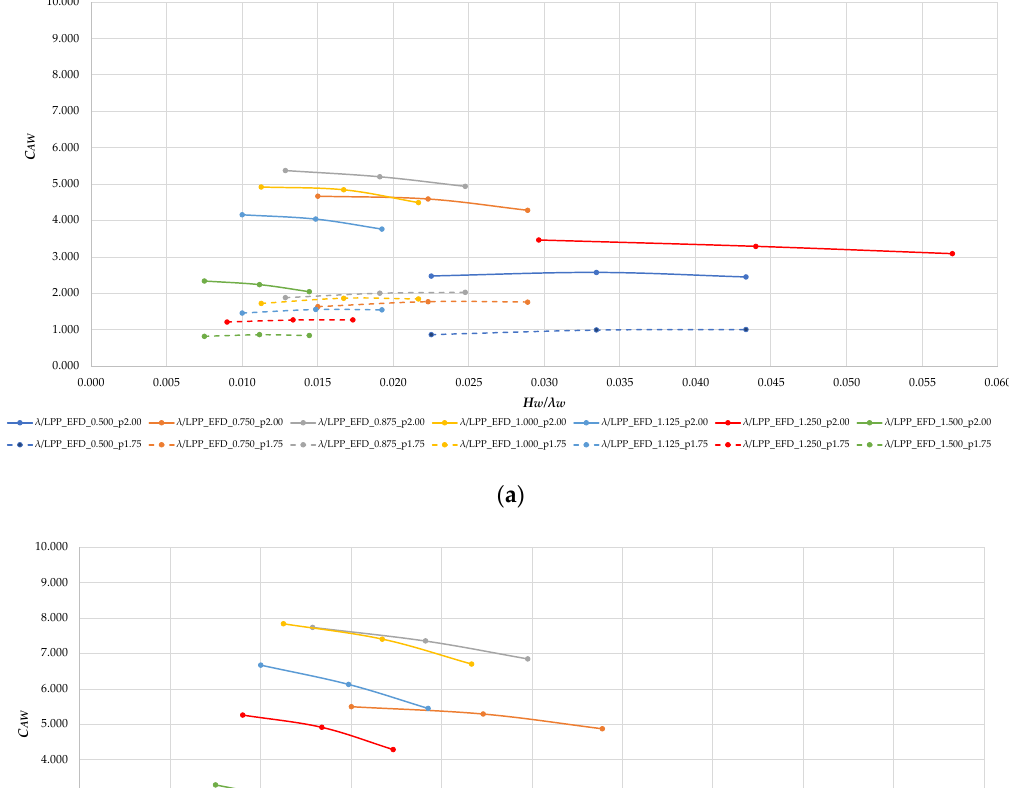
Figure 11. EFD results, steepness effect for each speed: ( a ) 𝐹 𝑅 = 0.131; ( b ) 𝐹 𝑅 = 0.174; ( c ) 𝐹 𝑅 = 0.218.